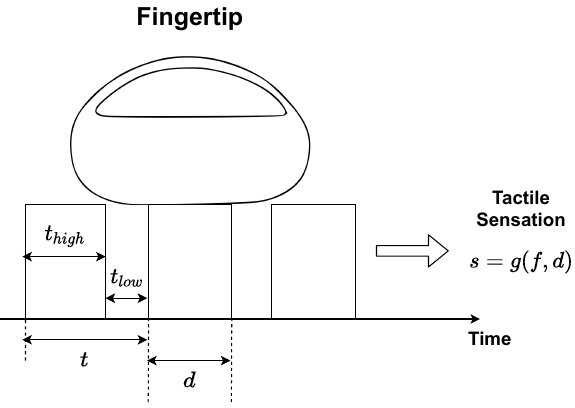
Figure 7. Tactile sensations of virtual textures, perceived through vibratory